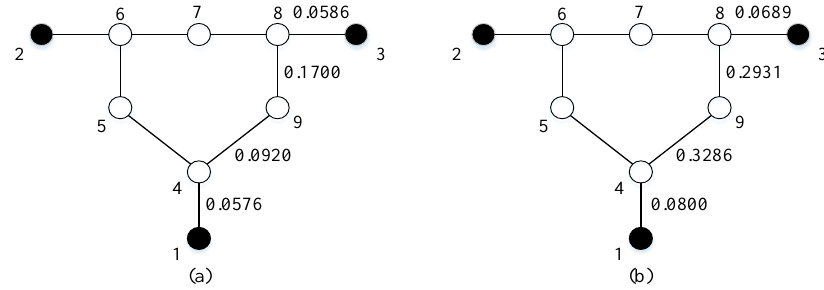
Figure 4. Graph-model of the IEEE-9 test system. ( a ) edge weight with x ij index; ( b ) edge weight with x ij / P ij index. Table 2. Minimum edge weight cumulative summation.